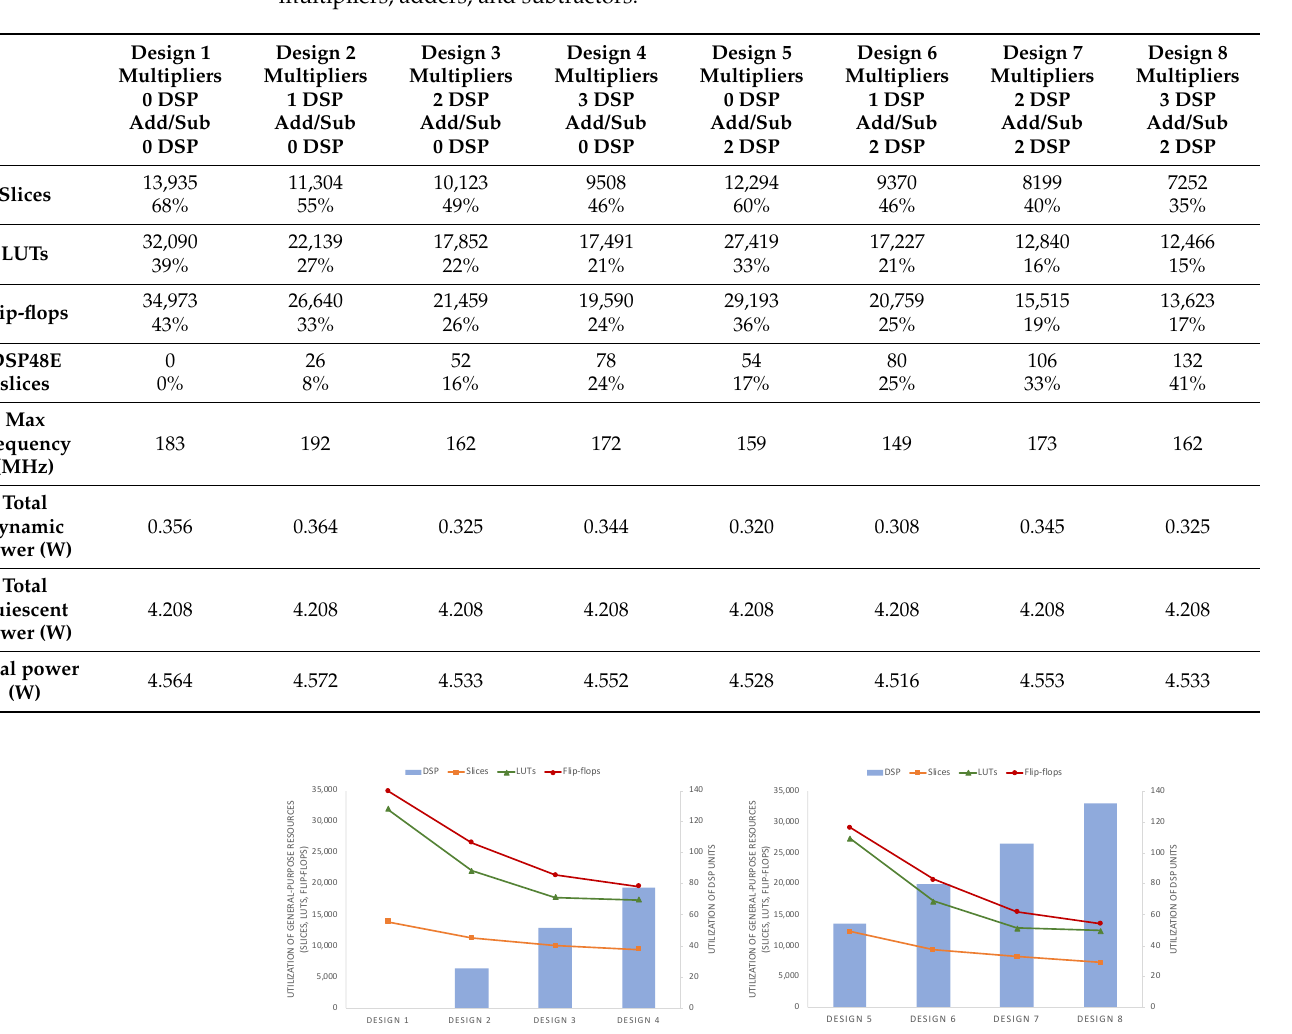
Figure 3. Design space exploration—utilization of DSP units and general-purpose resources (slices, LUTs, and flip-flops) for eight different design points using different numbers of DSP units for each floating-point multiply/add module: design 1 (zero DSP per multiplier, zero DSP per adder/subtractor), design 2 (one DSP per multiplier, zero DSP per adder/subtractor), design 3 (two DSP per multiplier, zero DSP per adder/subtractor), design 4 (three DSP per multiplier, zero DSP per adder/subtractor), design 5 (zero DSP per multiplier, two DSP per adder/subtractor), design 6